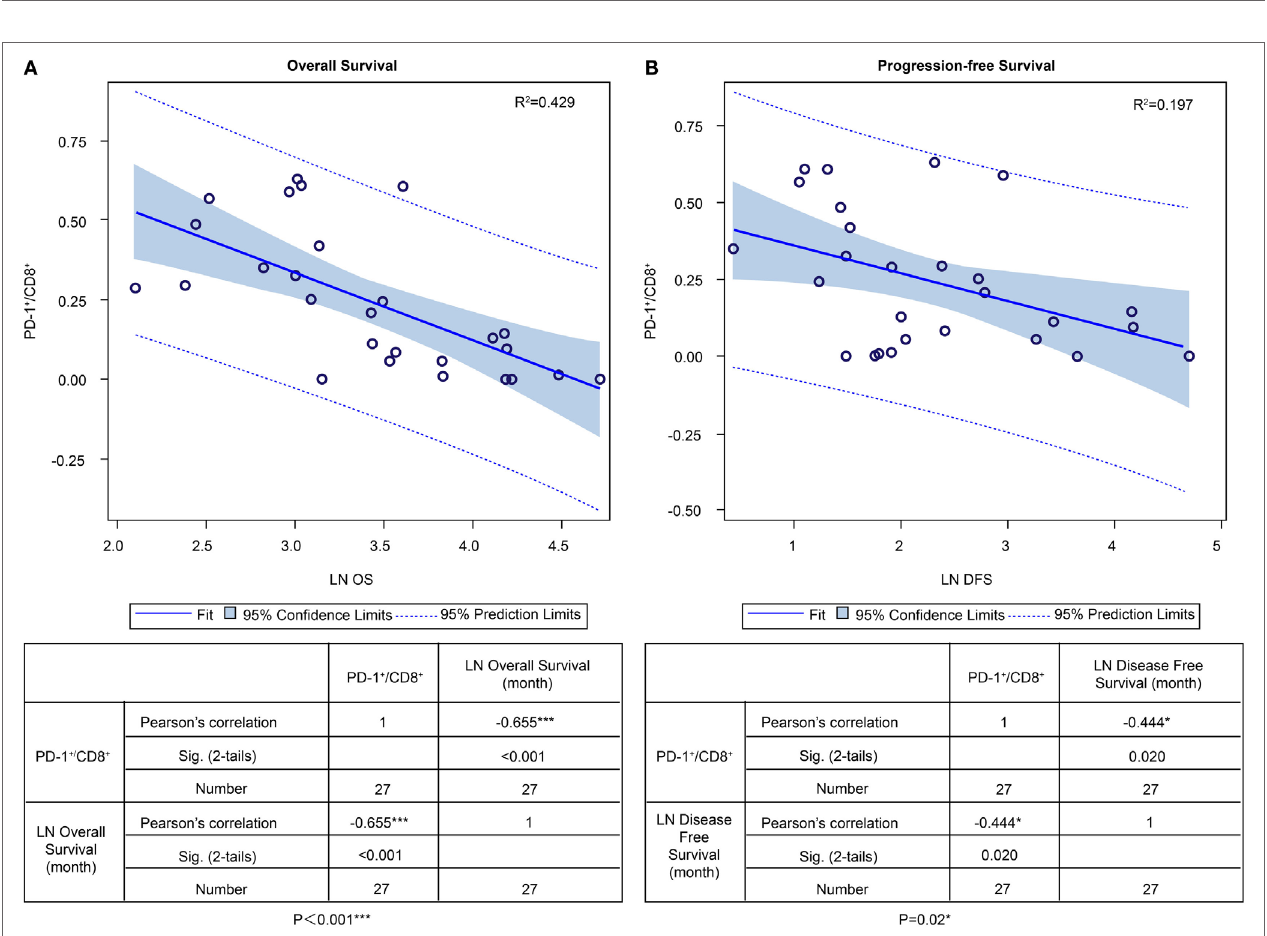
FigUre 5 | Overall survival (OS) (a) and progression-free survival (PFS) (B) by high or low PD-1 + /CD8 + ratio tumor-infiltrating lymphocytes in the ADCTA group. Kaplan–Meier survival plots of OS and PFS of 14 patients with high PD-1 + /CD8 + ratio compared to 13 patients with low PD-1 + /CD8 + ratio